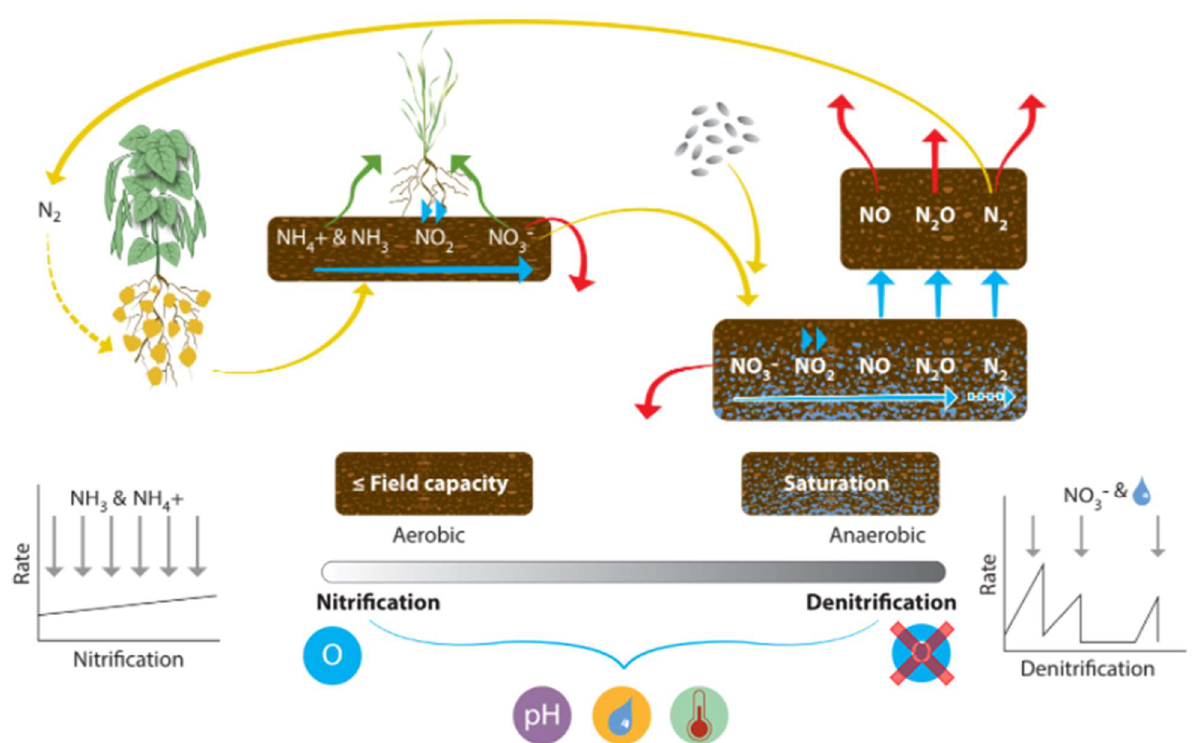
Figure 8. The nitrification-denitrification process that regulates change in the soil solution and plant- available N pools. Icons show: crop uptake, mineral and legume plants (nitrogen fixing), oxygen availability, pH, water availability and temperature.